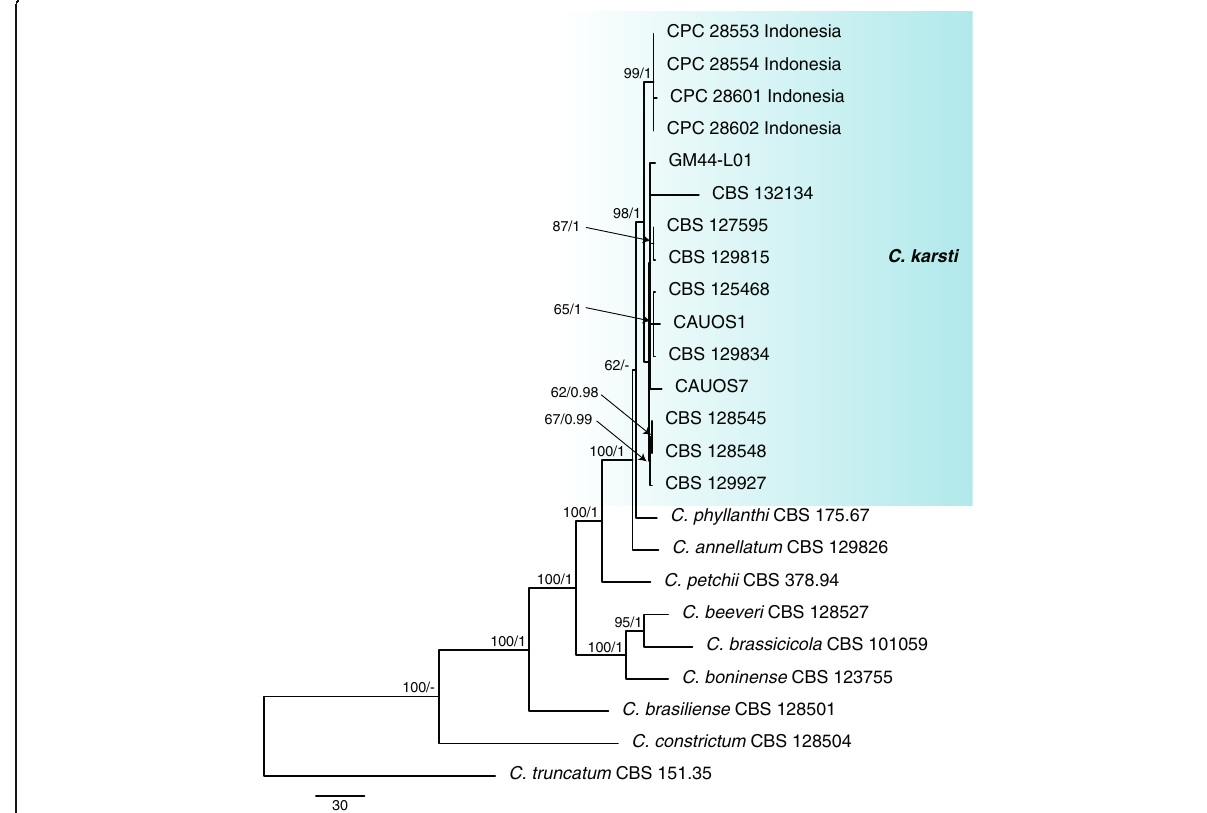
Fig. 2 First of three equally most parsimonious trees obtained from a heuristic search of the combined ITS, tub2 , gapdh , chs-1 sequence alignment of the Colletotrichum isolates in the boninense complex. The parsimony bootstrap support values (MP > 49%) and Bayesian posterior probabilities (PP > 0.90) are displayed at the nodes (MP/PP). The tree was rooted to C. truncatum (CBS 151.35). The bar indicates 30 changes. Coloured blocks are used to indicate clades containing isolates from